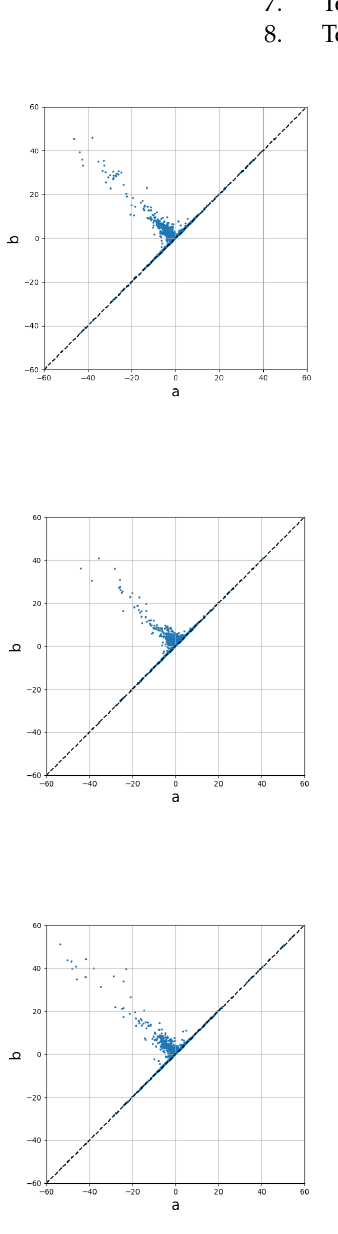
Figure A3. Relaxed passenger with SAV